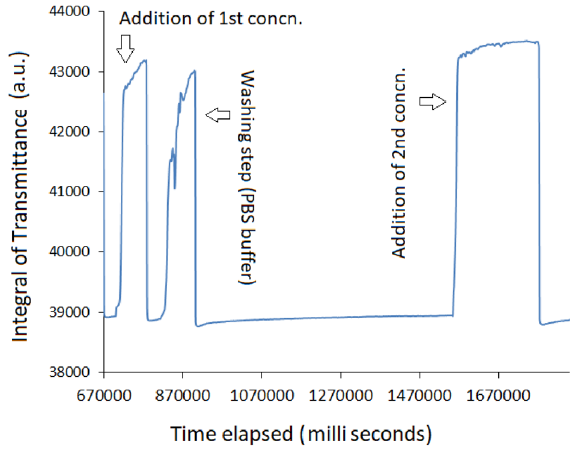
Figure 9. Time dependent transmission response of Ab(IgG)/L-Cysteine/MoS 2 /OF-SPR biosensor for two different concentrations.